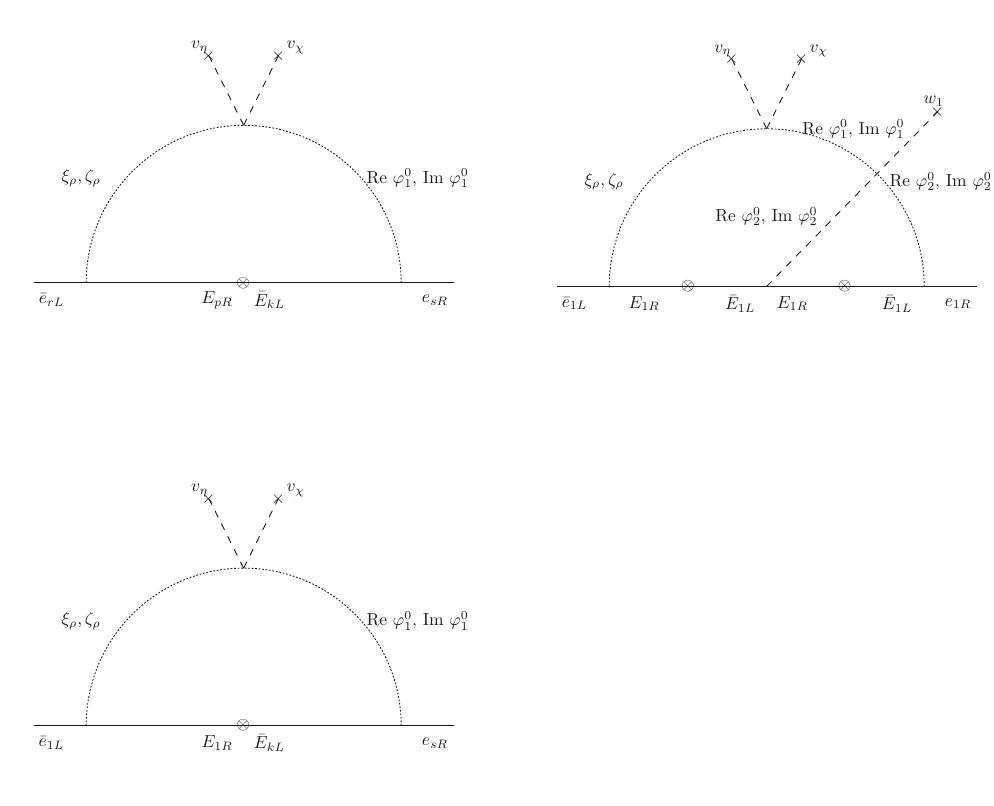
Figure 2 . Loop Feynman diagrams contributing to the entries of the charged lepton mass matrices. Here k; p; r; s = 2 ; 3 and w 1 corresponds to the mass dimension coe(cid:14)cients of the trilinear scalar coupling (cid:3) . The cross marks in the internal lines denote the m E mass insertions from eq.